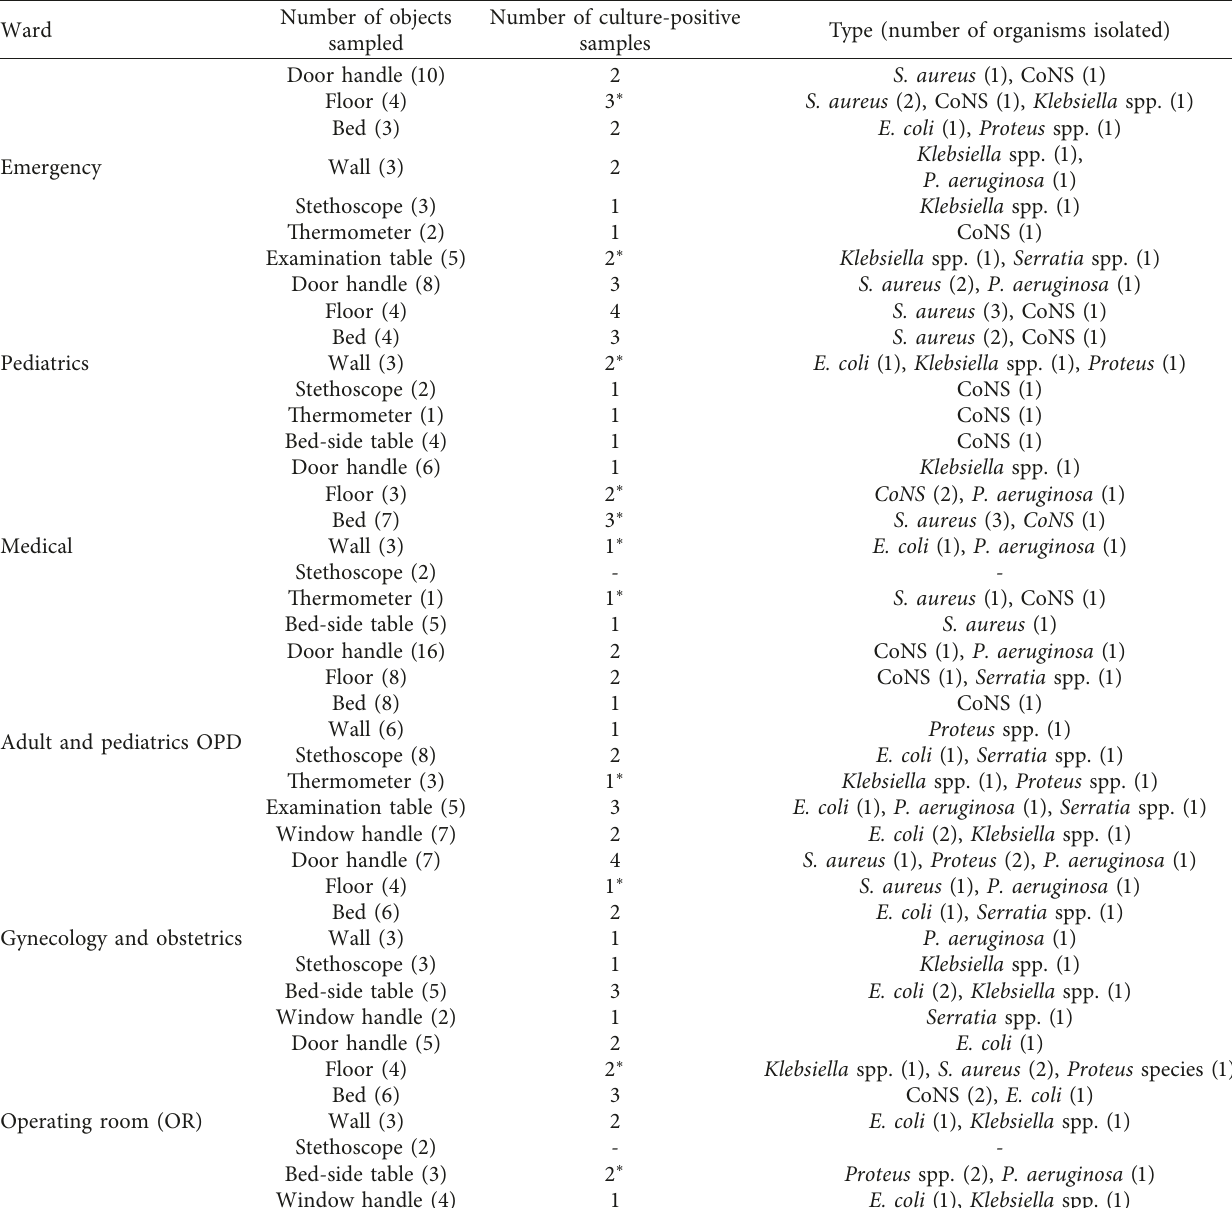
Table 1: Type and number of materials or surfaces screened for nosocomial bacteria at Mizan-Tepi University Teaching Hospital, 2017.